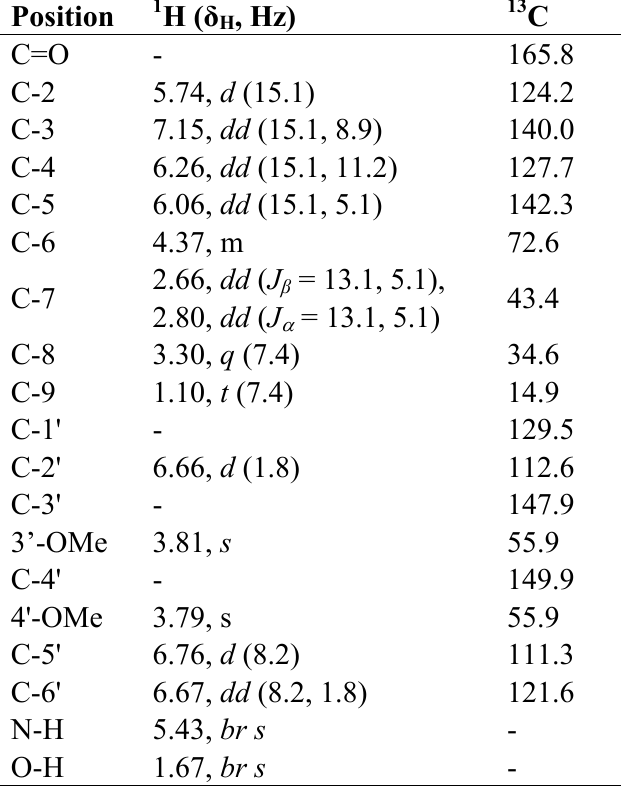
Table 1. 1 H-NMR (400 MHz) and 13 C-NMR (100 MHz) spectral data of ( − )-kunstleramide ( 1 ) in CDCl